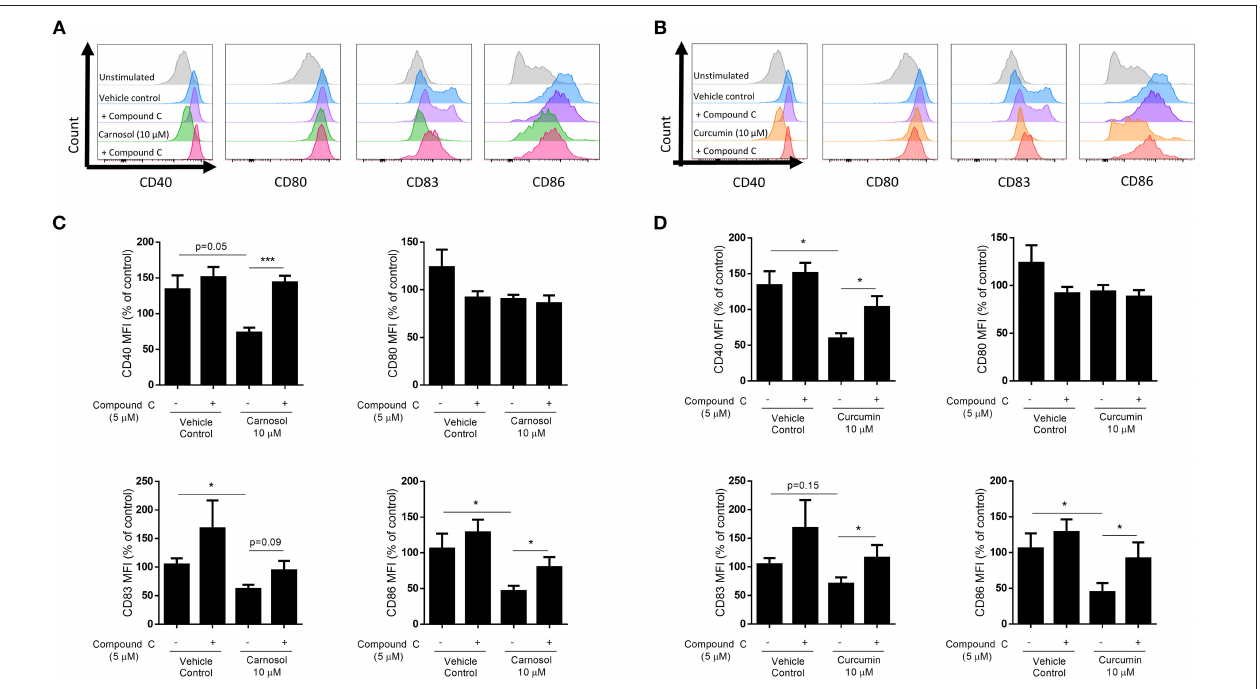
FIGURE 4 | Inhibition of AMPK attenuates reduction of DC maturation markers by carnosol and curcumin. Primary human DC ( n = 7) were incubated with or without compound C (5 µ M) for 1h prior to treatment with carnosol (10 µ M), curcumin (10 µ M), or a vehicle control for 6h. DC were then stimulated with LPS (100ng/ml) and expression of maturation markers CD40, CD80, CD83, and CD86 was determined after 24h by flow cytometry. Histograms depict expression of maturation markers in DC treated with (A) carnosol or (B) curcumin, with or without compound C, compared to controls from one representative experiment. Pooled data ( n = 7) depicts expression of CD40, CD80, CD83, and CD86 in DC treated with (C) carnosol or (D) curcumin, with or without compound C. Results shown are mean ( ± SEM) of the measured Mean Fluorescence Intensities (MFI), expressed as percentages of the vehicle control. Statistical significance was determined by repeated measures one-way ANOVA, with Sidak’s multiple comparisons post hoc test to compare pre-selected group pairs (*** p < 0.001, * p <